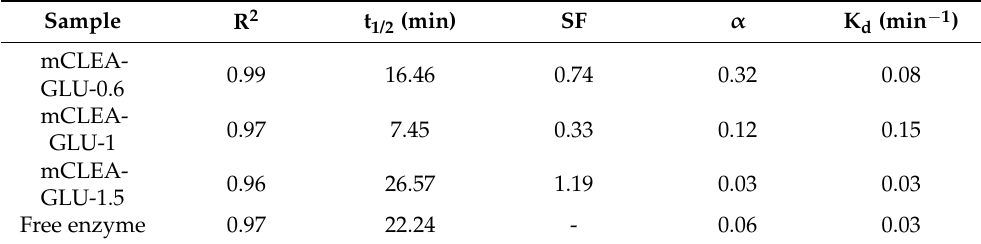
Table 2. Sadana and Henley model parameters for thermal inactivation at 60 ◦ C of the free enzyme and mCLEA of β -galactosidase produced with different concentrations of